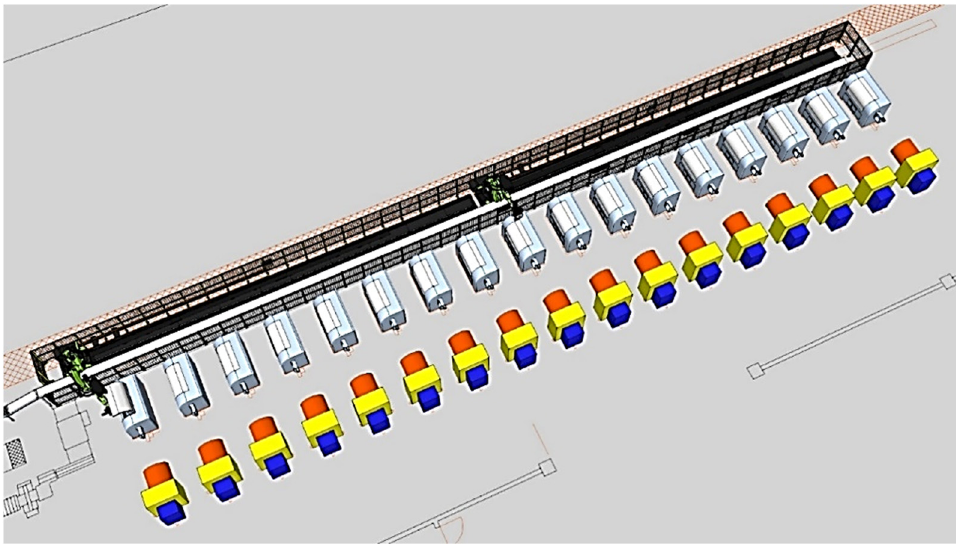
Figure 27. Designed line with 17 winders and their feeders (Image from KUKA SIMPRO).